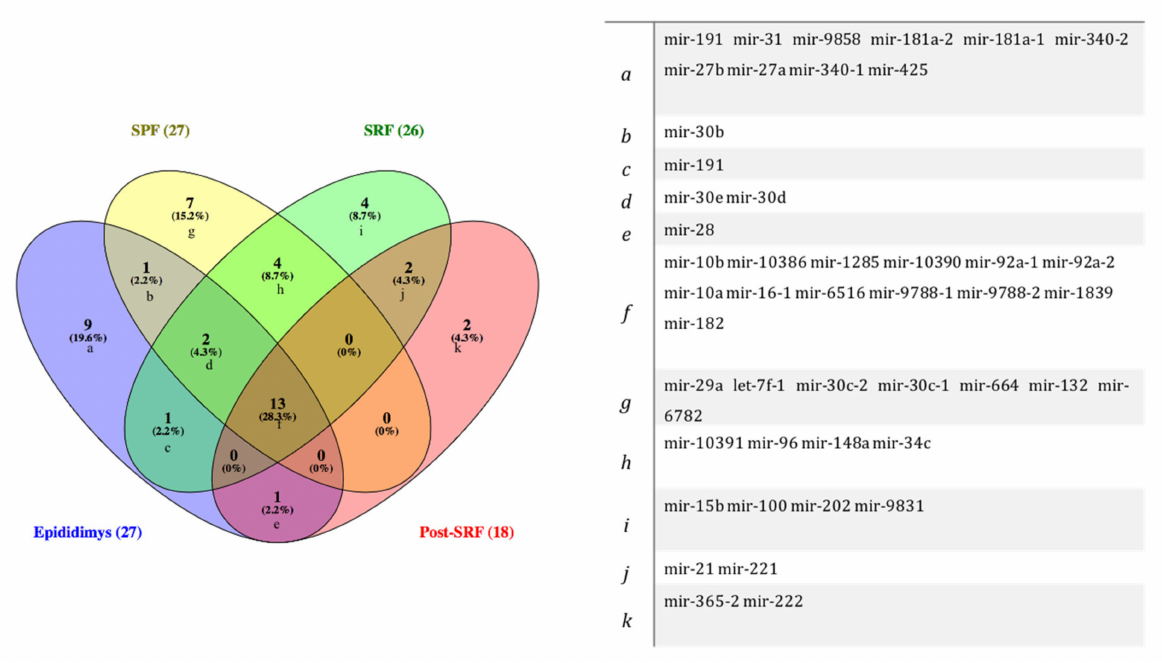
Figure 1. Venn diagram showing microRNAs (miRNAs) commonly identified among spermatozoa recovered from three ejaculate fractions: sperm peak fraction (SPF), sperm rich fraction (SRF), and post-SRF, and from the functional epididymal terminal segment